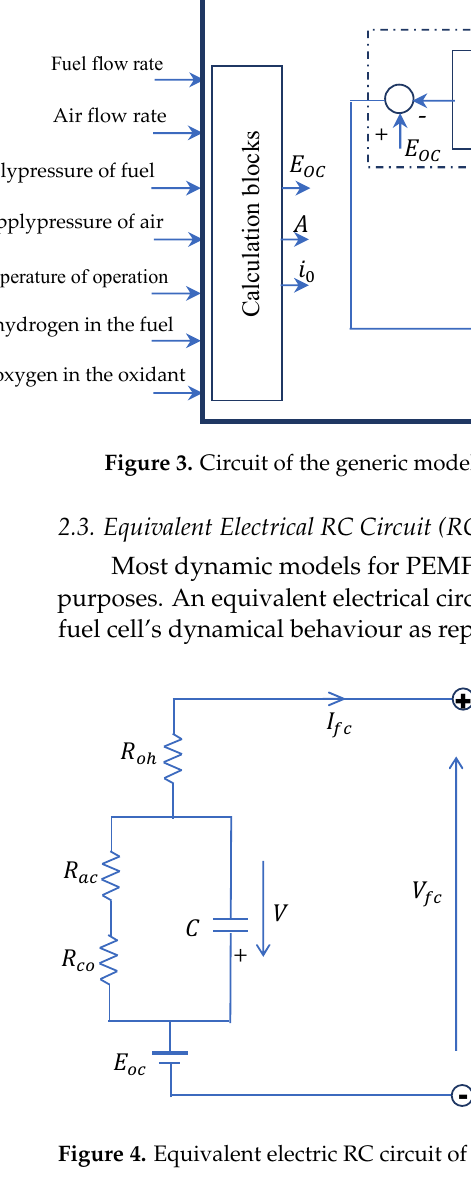
Figure 4. Equivalent electric RC circuit of a fuel cell stack.